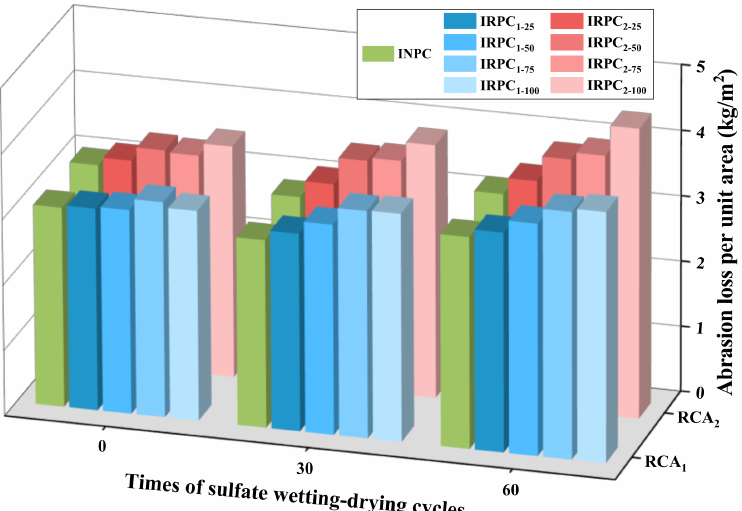
Figure 8. Abrasion loss per unit area on the internal layer of IRPC with variable replacement rates after different sulfate wetting-drying